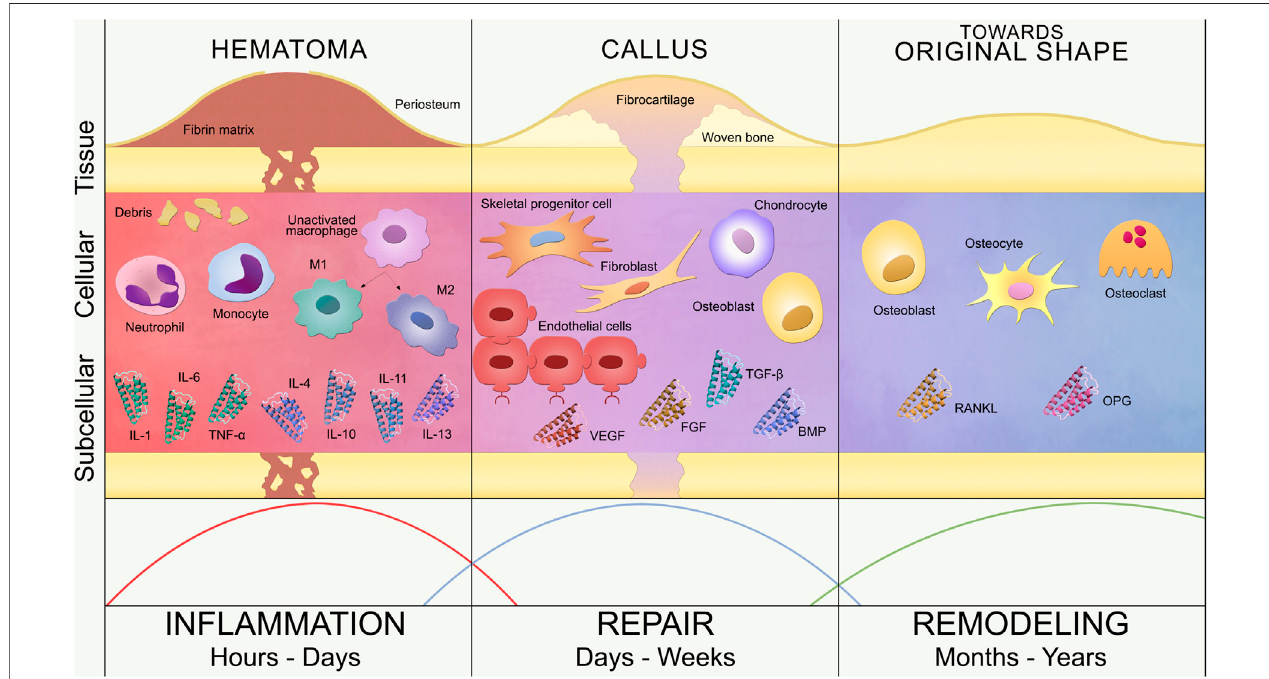
FIGURE 1| Bone fracture healing process. Timeline ofsecondary bone healingphases: in fl ammation, repair and remodeling. Tissue, cellular and subcellular levels are represented. In fl ammation (left): hematoma formation triggers the invasion of in fl ammatory cells (neutrophils, monocytes and macrophages) and the release of pro- in fl ammatory (IL-1,IL-6,TNF- α )andanti-in fl ammatory(IL-4, IL-10,IL-11,IL-13)cytokines.Unactivatedmacrophagesdifferentiateintoclassical(M1)andalternative (M2) activated macrophages. Repair (center): revascularization (endothelial cells), soft callus formation ( fi brocartilage) and subsequent hard callus formation (woven bone) are regulated by repair cells (SPCs, fi broblasts, chondrocytes and osteoblasts) and growth factors (VEGF, FGF, BMP, TGF- β ). Remodeling (right): restoration of the bone originalshape byosteoblasts, osteocytes and osteoclasts, regulated by RANKL/OPG balance. Thesethree phases are not rigidly de fi ned over the timeline but overlap, as represented by the curves at the bottom of the